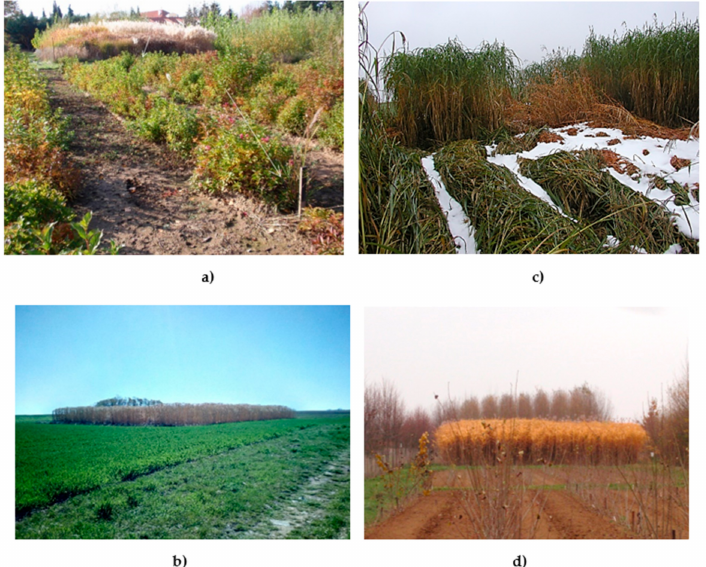
Figure 2. Pictures of experimental sites with Miscanthus : ( a ) Genotype collection Pr˚uhonice- Zelin á ˇrsk á zahrada with marked seedlings of Miscanthus sinensis invading the neighboring nursery in 2008; ( b ) Clonal experiment in Lukavec before spring harvest 2019; ( c ) Clonal experiment in Lukavec—lodging of Miscanthus sinensis (clone M4 GOFAL) under early snow in October 2009; ( d ) Clonal experiment in Pr˚uhonice-Michovky in October 2014.